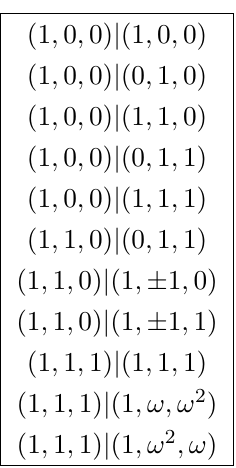
Table 1 . List of VEV directions for the potential of two triplets of (cid:1)(6 n 2 ), V